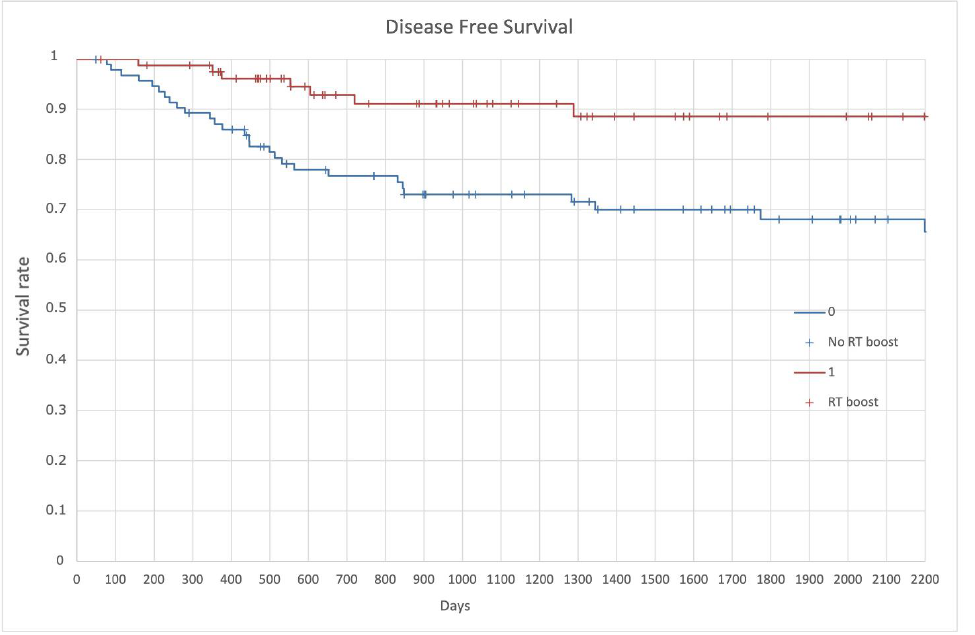
Figure 5. Disease Free Survival (DFS).